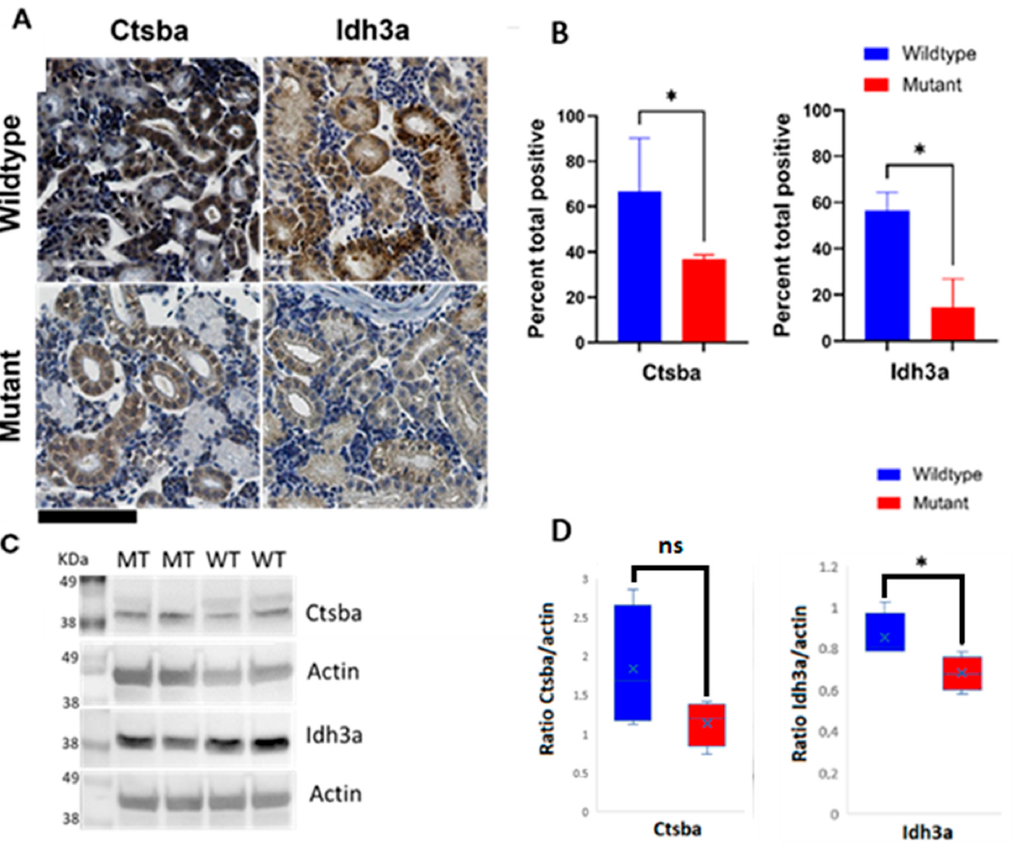
Figure 4. Immunohistochemical and Western blot detection of selected proteins in kidneys from WT and M ZF reveals protein expression disturbances in mitochondria and lysosomes. ( A ) Representative IHC staining specific for mitochondrial marker isocitrate dehydrogenase (NAD (+) )3 alpha (Idh3a) and lysosomal marker cathepsin B (Ctsb) in kidney tissue sections from WT and M ZF ( upper right and upper left panels, and lower right and lower left panels, respectively; ( B ) Quantification of immunohistochemical staining of sections from WT and M ZF kidneys. Signal intensity is significantly higher in WT than in M for both proteins. ( C ) Representative immunoblots of Ctsb and Idh3a in kidney tissue section from WT and M ZF; ( D ) Quantification of immunoblots from WT and M ZF kidneys. (Mann–Whitney test U * p < 0.05). Wildtype (WT), mutant (M). ns: not significant. Scale bar ( bottom left corner, in black) = 100 µm.